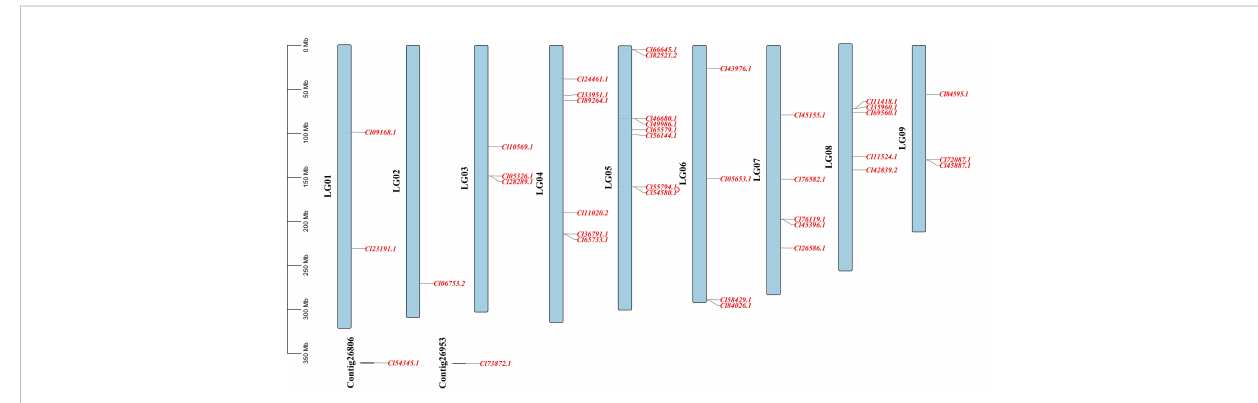
FIGURE 2 Localization and co-linearity of ClMIKCc on nine C. lavandulifolium chromosomes. The red line shown the co-linearity relationship between genes.